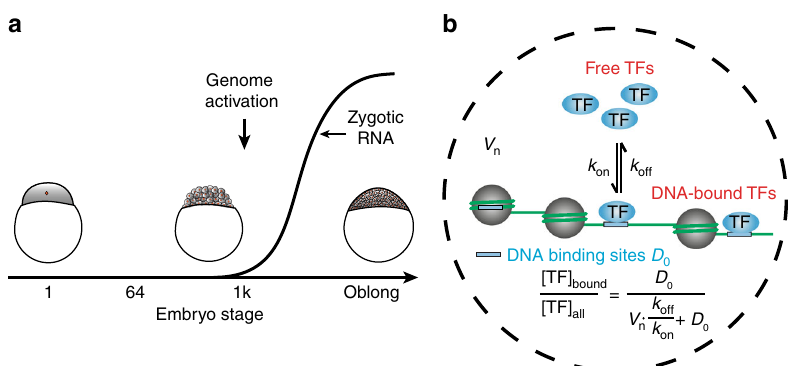
Fig. 1 TF binding and zygotic genome activation. a Sketch of zygotic mRNA levels as a function of embryo stage. Inset : schemes of embryos at different developmental stages. b Scheme of TF binding to chromatin: free TFs associate with rate constant k on to and dissociate with rate constant k off from an apparent number of chromatin binding sites D 0 . The concentrations of all species involved depend on their quantities and the nuclear volume V n . Inset : formula describing the chromatin-bound fraction of TFs that does not depend on the concentration